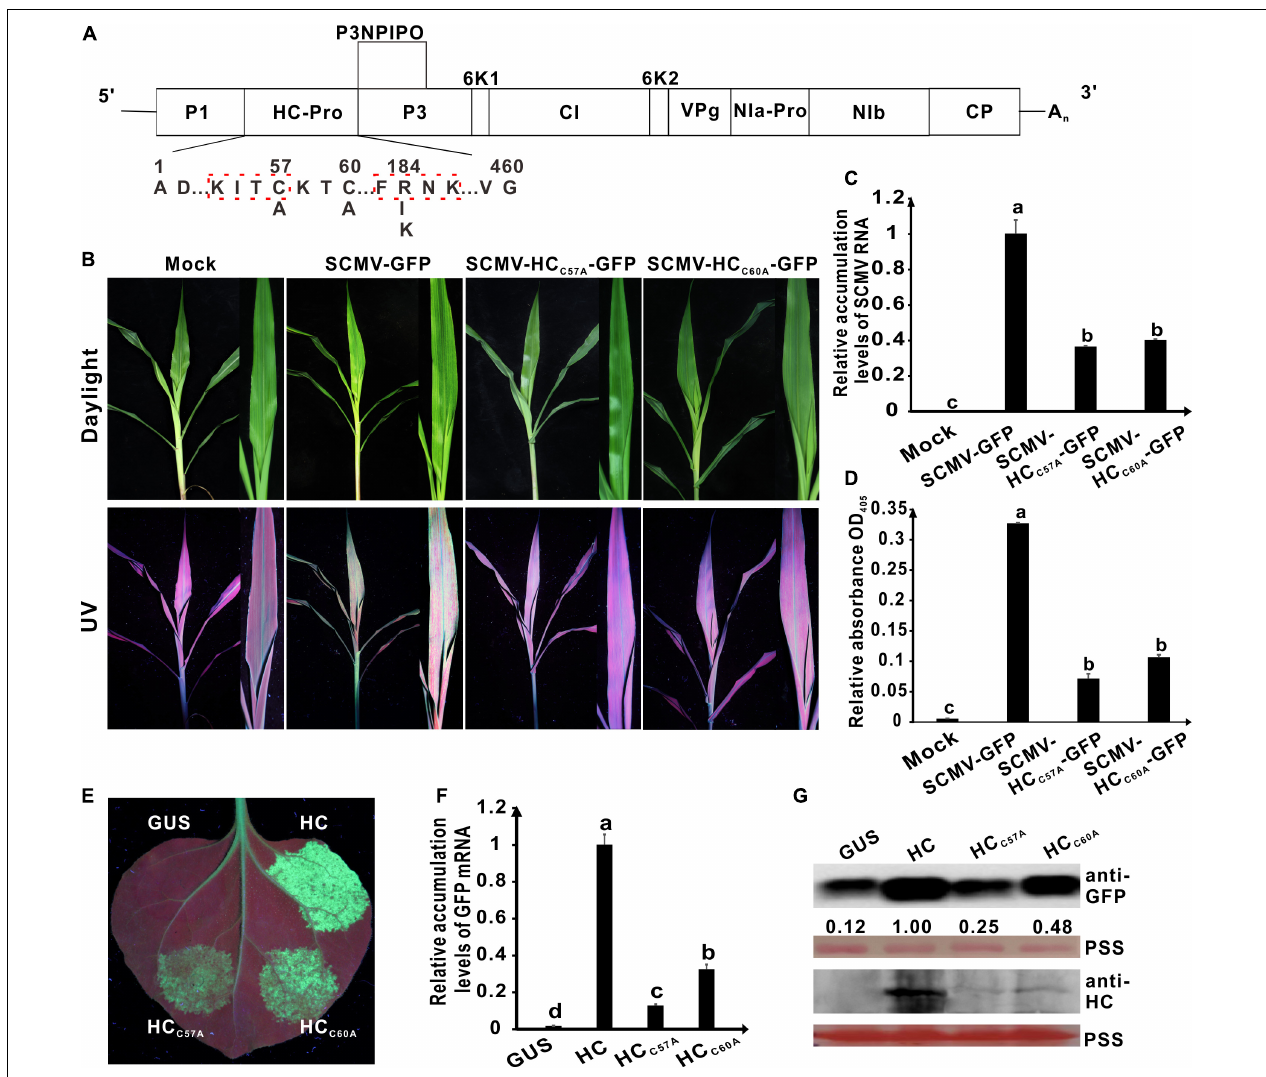
FIGURE 2 | Effects of the mutations in the conserved C 57 and C 60 of wild type HC-Pro on its RNA silencing suppression activity and virulence of SCMV. (A) Genetic map of SCMV, showing the all mutations in HC-Pro. The numbers above the sequence indicate their position in SCMV HC-Pro and the letters below the sequence showed the substituted residues at that position. The highly conserved KITC and FRNK motifs in SCMV HC-Pro were marked by the red dotted boxs. (B) Symptoms of SCMV and two SCMV mutants in maize plants at 10 days post inoculation (dpi). The conserved C 57 and C 60 in wild type SCMV HC-Pro were mutated to A residues in HC-Pros of SCMV-HC C 57 A -GFP and SCMV-HC C 60 A -GFP, respectively. Mock, the maize plants inoculated with the empty vector pCB301-Rz. SCMV-GFP, the maize plants infected with wild type SCMV with gfp reporter gene. (C) The wild type and mutant SCMV RNA accumulation levels in the upper leaves of maize plants at 10 dpi. (D) ELISA analysis of the wild type and mutant SCMV accumulation levels in the upper leaves of maize plants at 10 dpi. (E) The wild type and mutants HC-Pro RSS activity in Agrobacterium co-infiltration assay. The N. benthamiana 16C leaves were infiltrated with a mixture of Agrobacterium cultures carrying pBin-GFP and either wild type or mutant HC-Pro and photographed under long-wavelength UV light at 3 days post agroinfiltration (dpai). The conserved C residues in wild type HC-Pro (HC) were mutated to A residues in HC C 57 A and HC C 60 A , respectively. The GUS was used as a negative control. (F) The GFP mRNA accumulation levels in agroinfiltrated 16C leaf patches. (G) Western blotting analysis of the accumulation levels of GFP and HC in agroinfiltrated leaf patches of 16C. The ponceau S staining (PSS) shows sample loadings. Band intensities were measured using the ImageJ software. Numbers indicate the accumulation levels of SCMV CP normalized to PSS staining. Error bars indicate the means ± standard deviation of three replicates. Statistical significance was determined by employing Tukey multiple range test for between-group comparisons. Different letters indicate significant differences ( P < 0.05). The same below. The experiments were repeated thrice